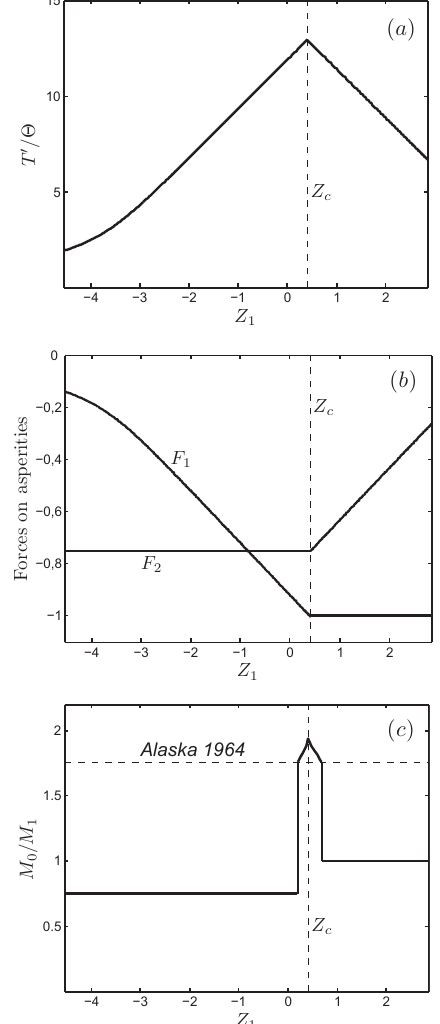
Figure 5. (a) Duration T (cid:48) of the interseismic interval following an event with mode sequence 10–01, (b) forces F 1 and F 2 on the as- perities at the beginning of the subsequent event, and (c) seismic moment M 0 of the subsequent event, as functions of the variable Z 1 characterizing the initial state of the system. The values of pa- rameters are appropriate to the 1964 Alaska earthquake ( α = 0.1, β = 0.75, (cid:15) = 0.7, V (cid:50) =